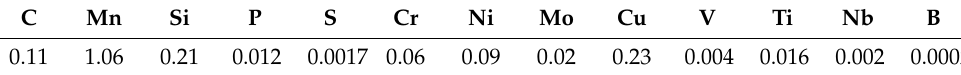
Table 1. Chemical Composition of API 5L X65 (wt. %).